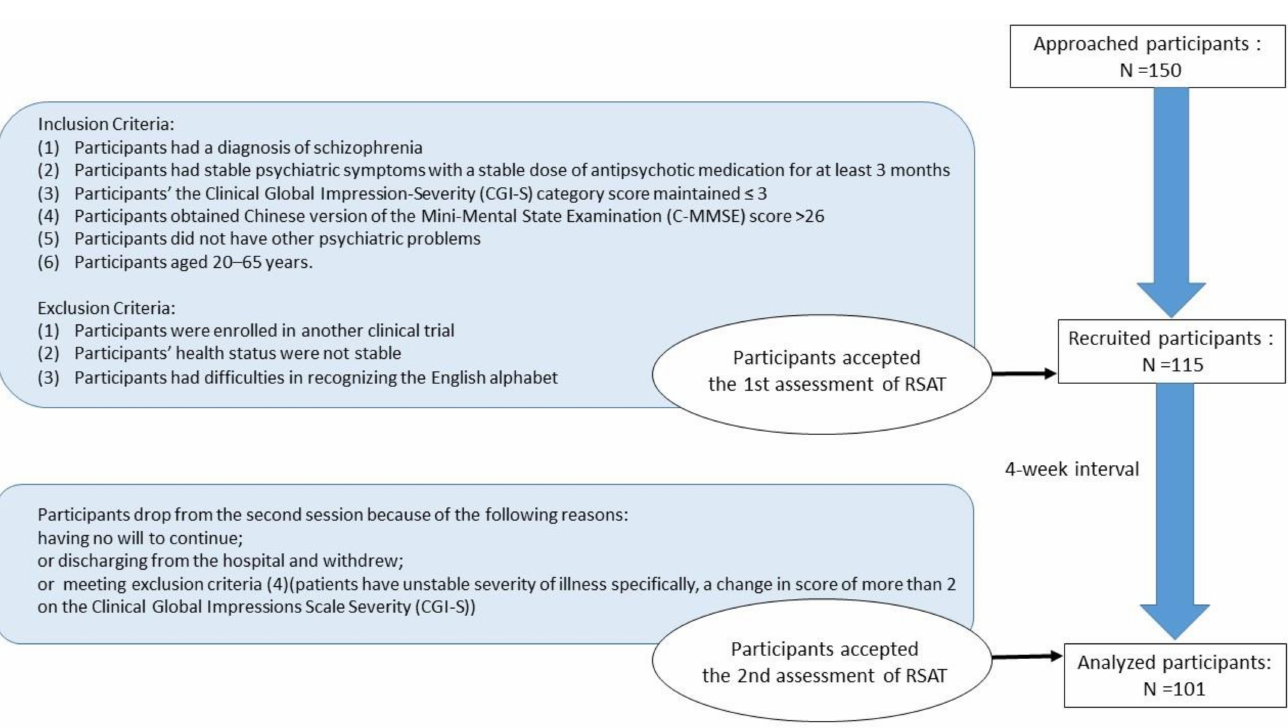
Figure 1. The flowchart of the